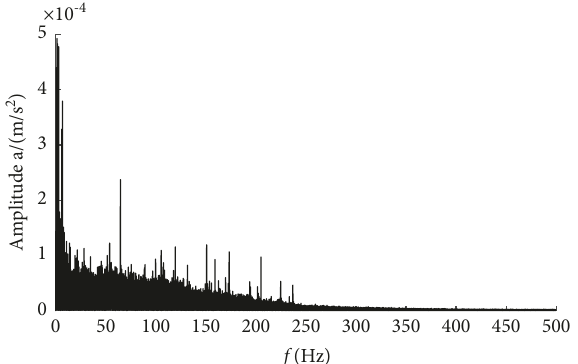
Figure 13: The envelope spectrum of the first component derived from MBMD decomposition of a vibration signal from class 3.